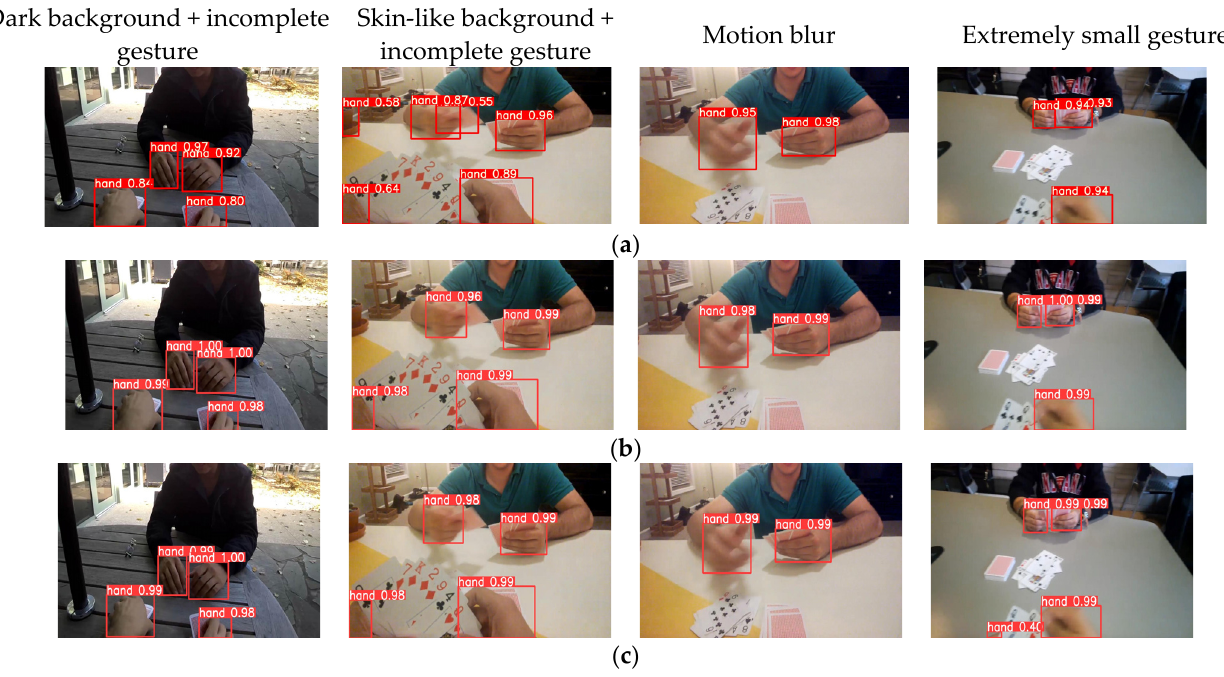
Figure 5. Comparison of detection results of different methods; ( a ) Results of YOLOv7; ( b ) Results of YOLOv5l; ( c ) Results of proposed method.